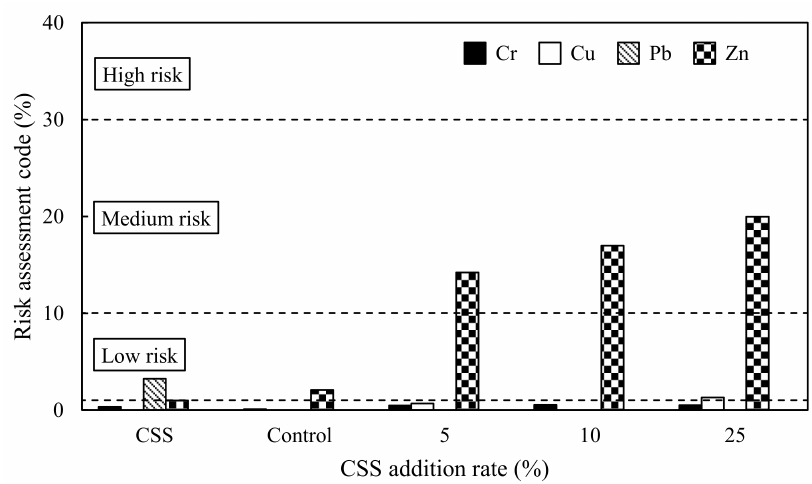
Figure 4. Risk assessment code (RAC) for heavy metals in the CSS, control, and amended soil. The dashed lines indicate critical RAC values at low risk, medium risk, and high risk,